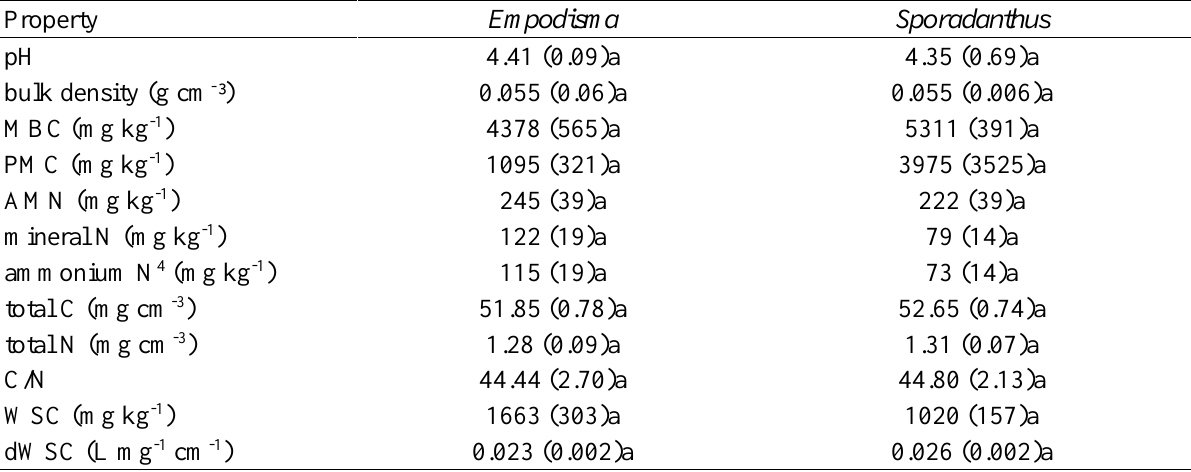
Table 2. Biochemical properties of peat under Empodisma and Sporadanthus , with no differentiation between hydrological zones or sites. AMN = anaerobically mineralisable nitrogen, dWSC = decomposability of water- soluble carbon, MBC = microbial biomass carbon, PMC = potentially mineralisable carbon, WSC = water- soluble carbon. Values in brackets represent the standard error of the mean ( n = 24). Values with different letters within a row are significantly different ( P <